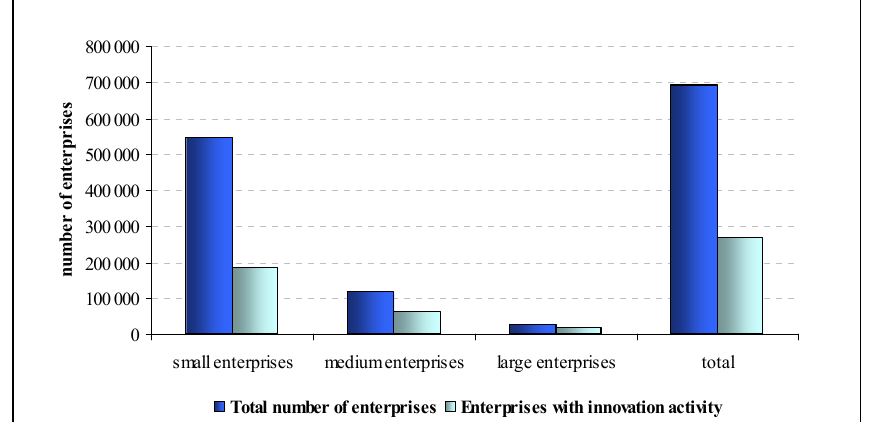
Figure 1 - The number of innovation active enterprises in EU 27 according to their size in